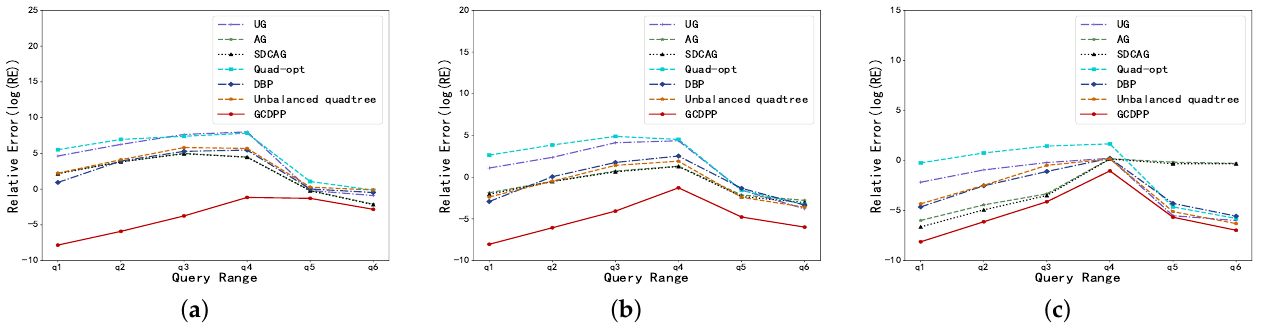
Figure 11. Comparison of querying accuracy on Storage dataset. ( a ) Storage dataset, (cid:101) = 0.01; ( b ) Storage dataset, (cid:101) = 0.1; ( c ) Storage dataset, (cid:101) = 1.